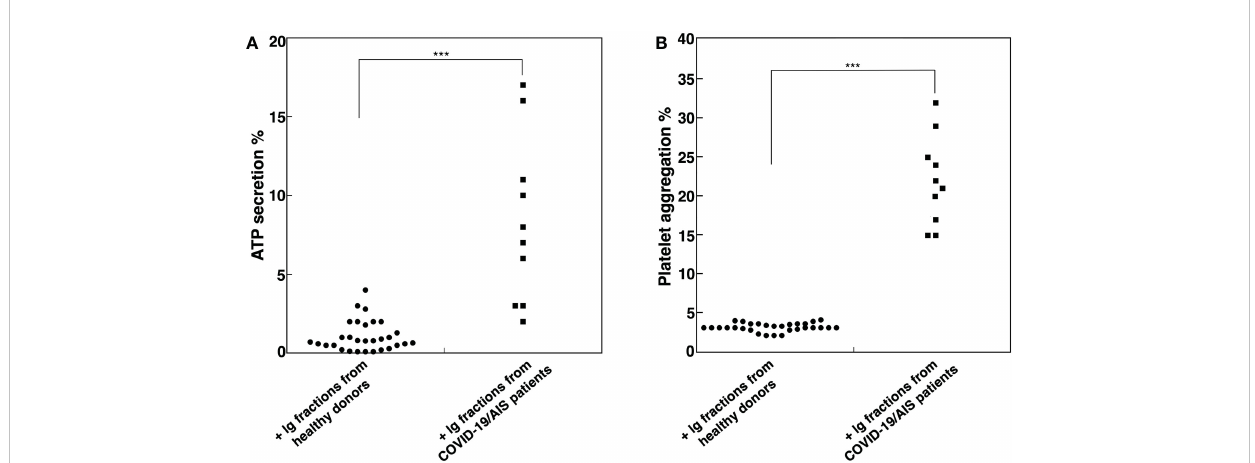
FIGURE 2 Ig fractions from patients with AIS during COVID-19 induce ATP release and platelet aggregation. Human platelets from healthy donors were treated with Ig fractions (200 m g/ml) from 10 patients with AIS during COVID-19 and from 30 healthy donors. After treatments, platelets were analyzed: (A) for ATP release dosage by a luciferin/luciferase method to evaluate platelet secretion; (B) for platelet aggregation. Statistical analysis indicates: ***p < 0.001 vs healthy